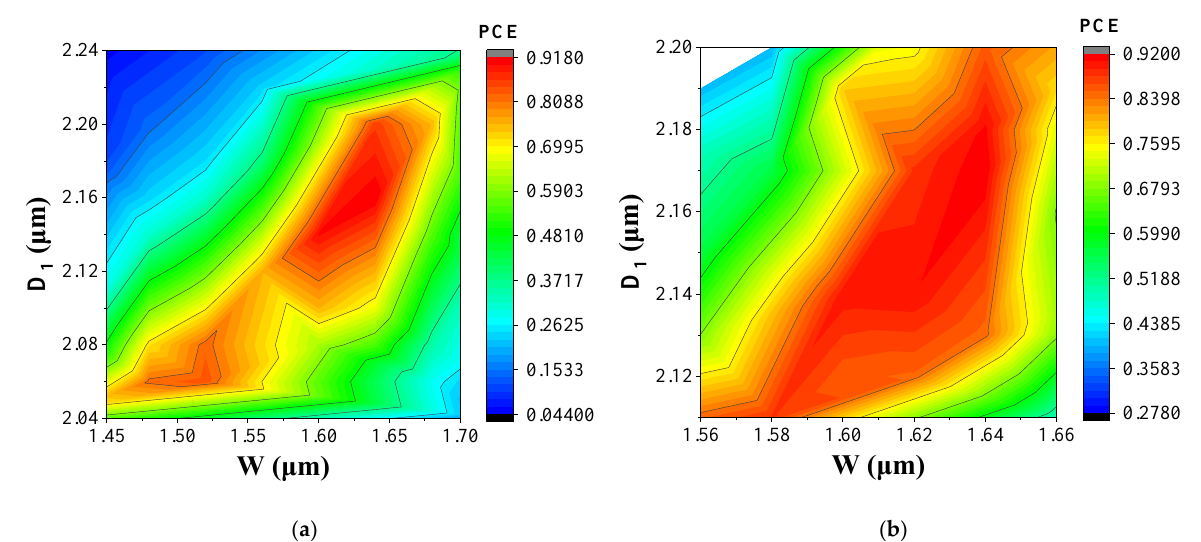
Figure 5. Maximum TE – TM PCE as a function of waveguide width ( W ) and shallow etched depth ( D 1 ) from ( a ) broad- range optimization and ( b ) narrow-range optimization. Table 2. Three profiles of waveguide parameters.